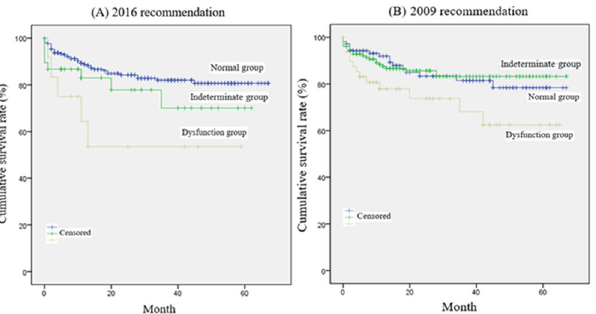
Fig 2. Comparison of the overall patient survival rate between normal diastolic, indeterminate, and diastolic dysfunction groups according to (A) the 2016 recommendations and (B) the 2009 recommendations in living- donor liver transplantation. (A) According to the 2016 recommendations, overall patient survival was significantly different between the normal and dysfunction groups ( p = 0.007) but did not differ between the normal and indeterminate groups ( p = 0.183) or between the indeterminate and dysfunction groups ( p = 0.223). The 1-, 3- and 5-year survival rates were 98%, 93%, and 91% in the normal group; 87%, 70%, and 70% in the indeterminate group; and 64%, 54%, and 54% in the dysfunction group, respectively. (B) According to the 2009 recommendations, overall patient survival was significantly different between the normal and dysfunction groups ( p = 0.042) and between the indeterminate and dysfunction groups ( p = 0.027), but not between the normal and indeterminate groups ( p = 0.836). The 1-, 3-, and 5-year survival rates were 94%, 92%, and 83% in the normal group; 95%, 91%, and 87% in the indeterminate group; and 83%, 74%, and 62% in the dysfunction group,